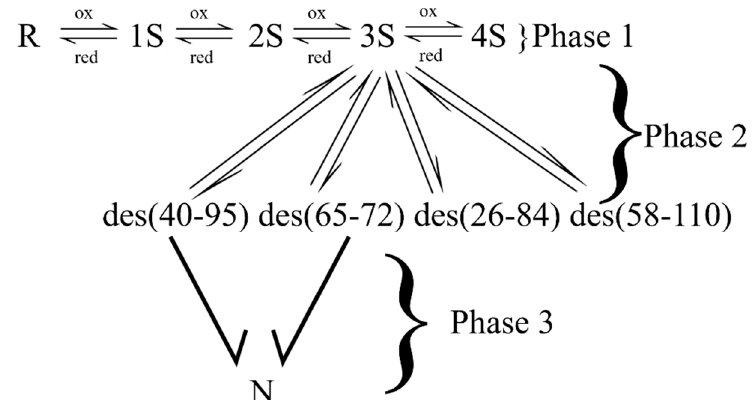
Figure 1. The oxidative folding pathway of RNase A (at 5 ◦ C). In Phase I, unstructured intermediates form a quasi-equilibrium distribution. The structure is formed from 3S intermediates in a conformational folding step (Phase 2). The native protein (N) is formed upon the oxidation of des (40–95) and des (65–72) in Phase 3. The two other des species remain kinetically trapped.